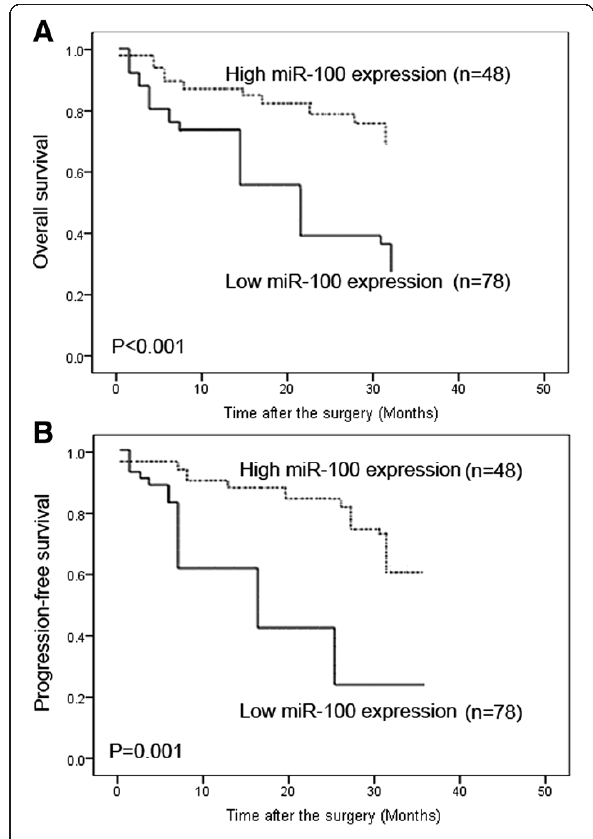
Figure 2 Kaplan-Meier survival curves for bladder cancer patients according to the expression of miR-100. ( A ) Progression-free survival (PFS); ( B ) overall survival (OS).